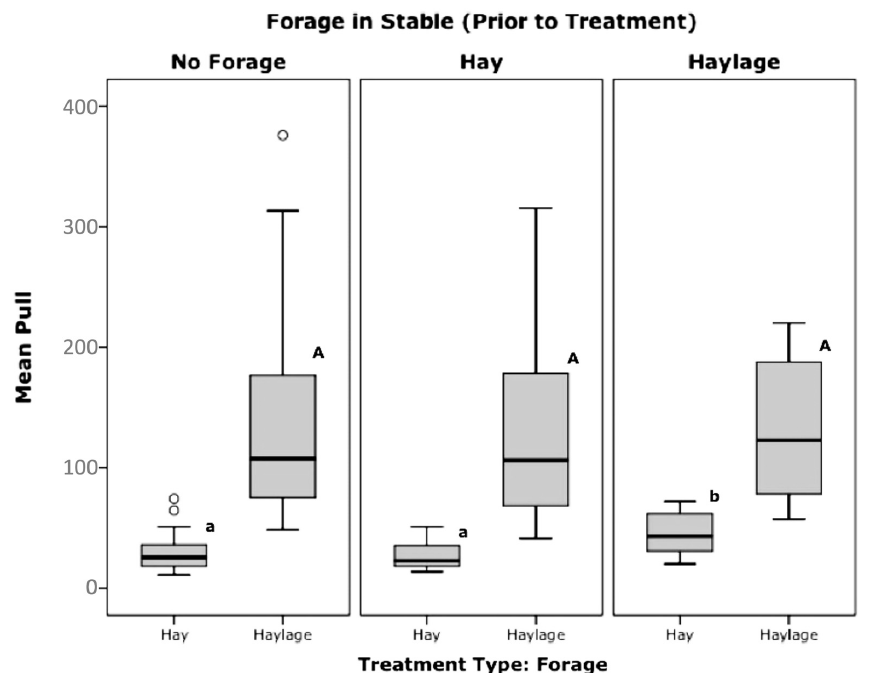
Figure 11. Pull pressures (kPa), grouped by ‘forage in stable prior to treatment’ and forage treatment (Significance between hay feeding tests are shown by lower case letters, and between haylage are shown by upper case letters, with those that do not share the same superscripts being significantly different, Anova, Bonferroni, p < 0.05; o =